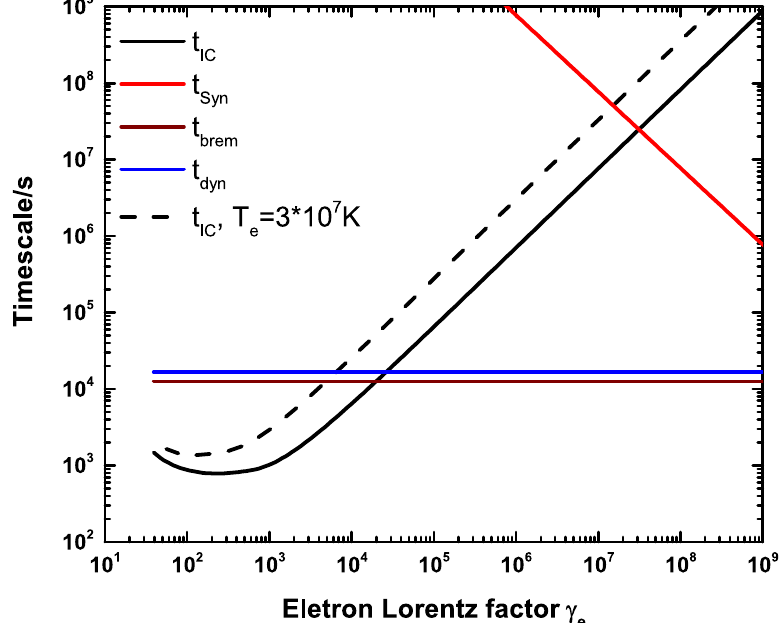
Figure 3. The synchrotron, IC, bremsstrahlung and dynamical timescales of electrons in the SMBH rest frame. The same parameters are adopted as in Figure